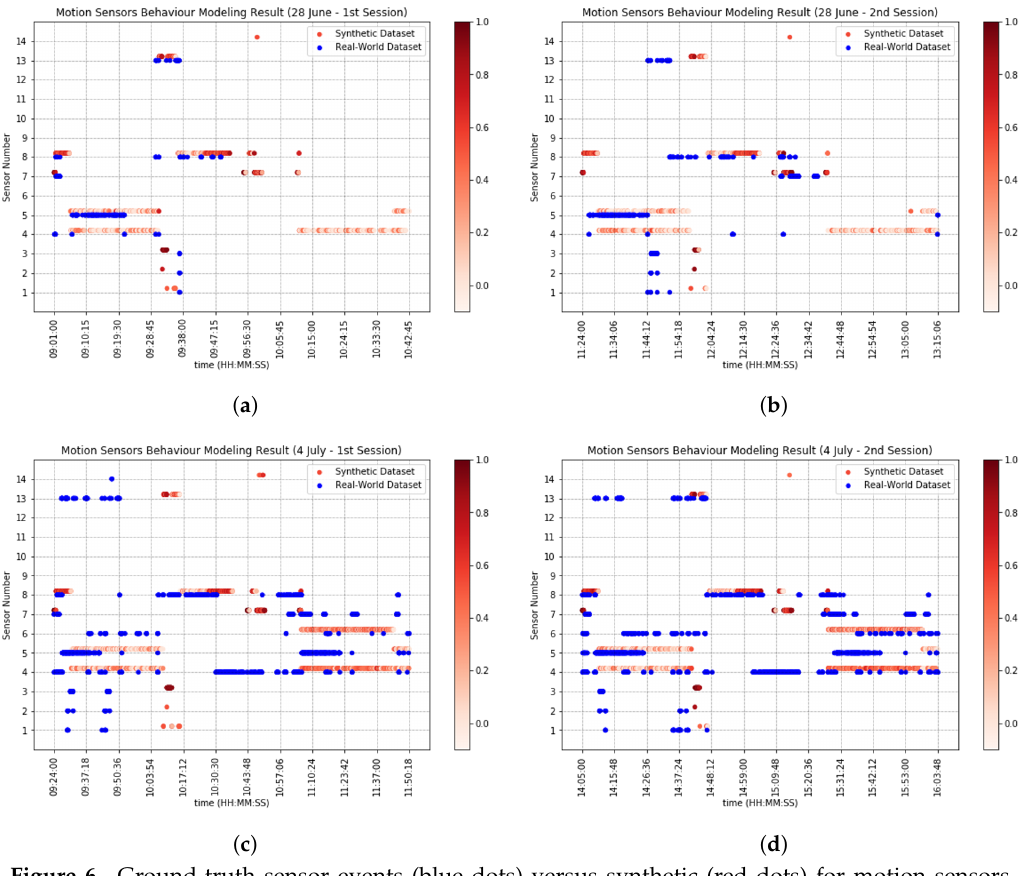
Figure 6. Ground-truth sensor events (blue dots) versus synthetic (red dots) for motion sensors only. Red dots are plotted slightly higher that the line of the particular sensor to avoid